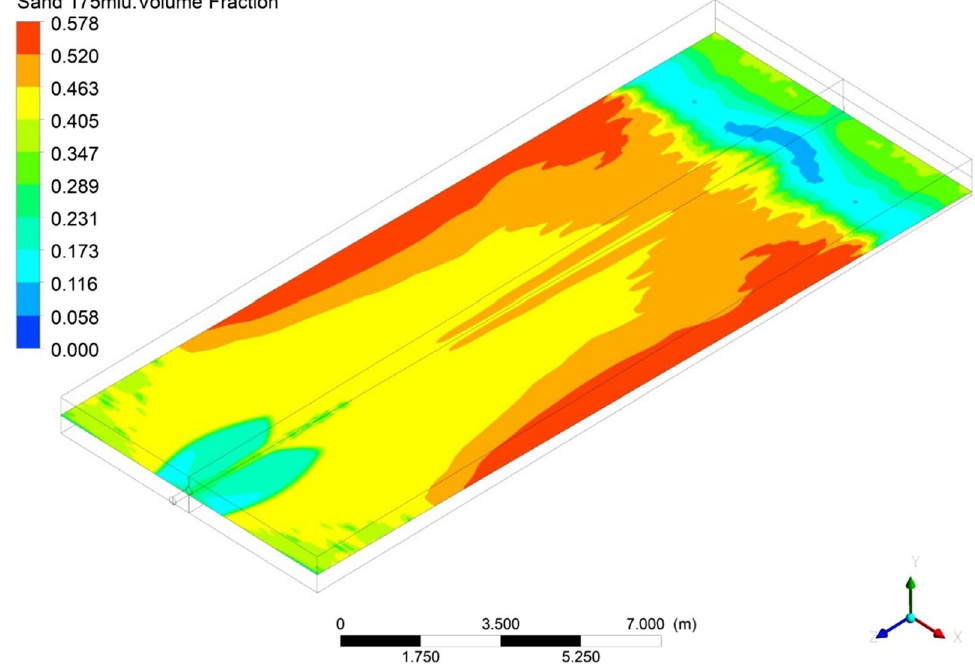
Fig. 15 Volume percentage of 175 μm sediment at 386.415